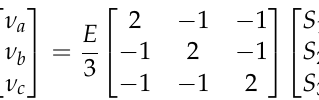
Figure 3. Back-to-back converter for IGBT voltage source converter.